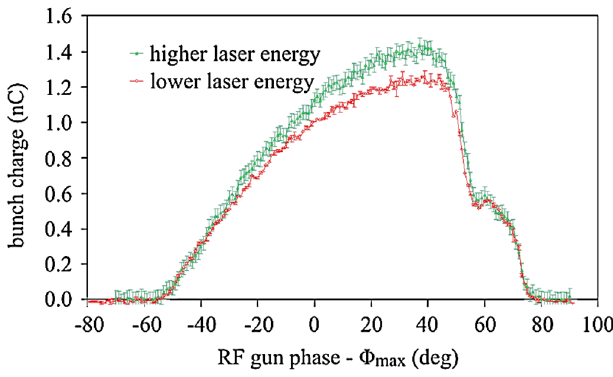
FIG. 18. (Color) Phase scan—electron bunch charge vs gun phase for different laser energies (laser transmission factors 33% and 40%). Zero phase ( rf gun phase ¼ (cid:1) the gun phase of the maximum mean momentum